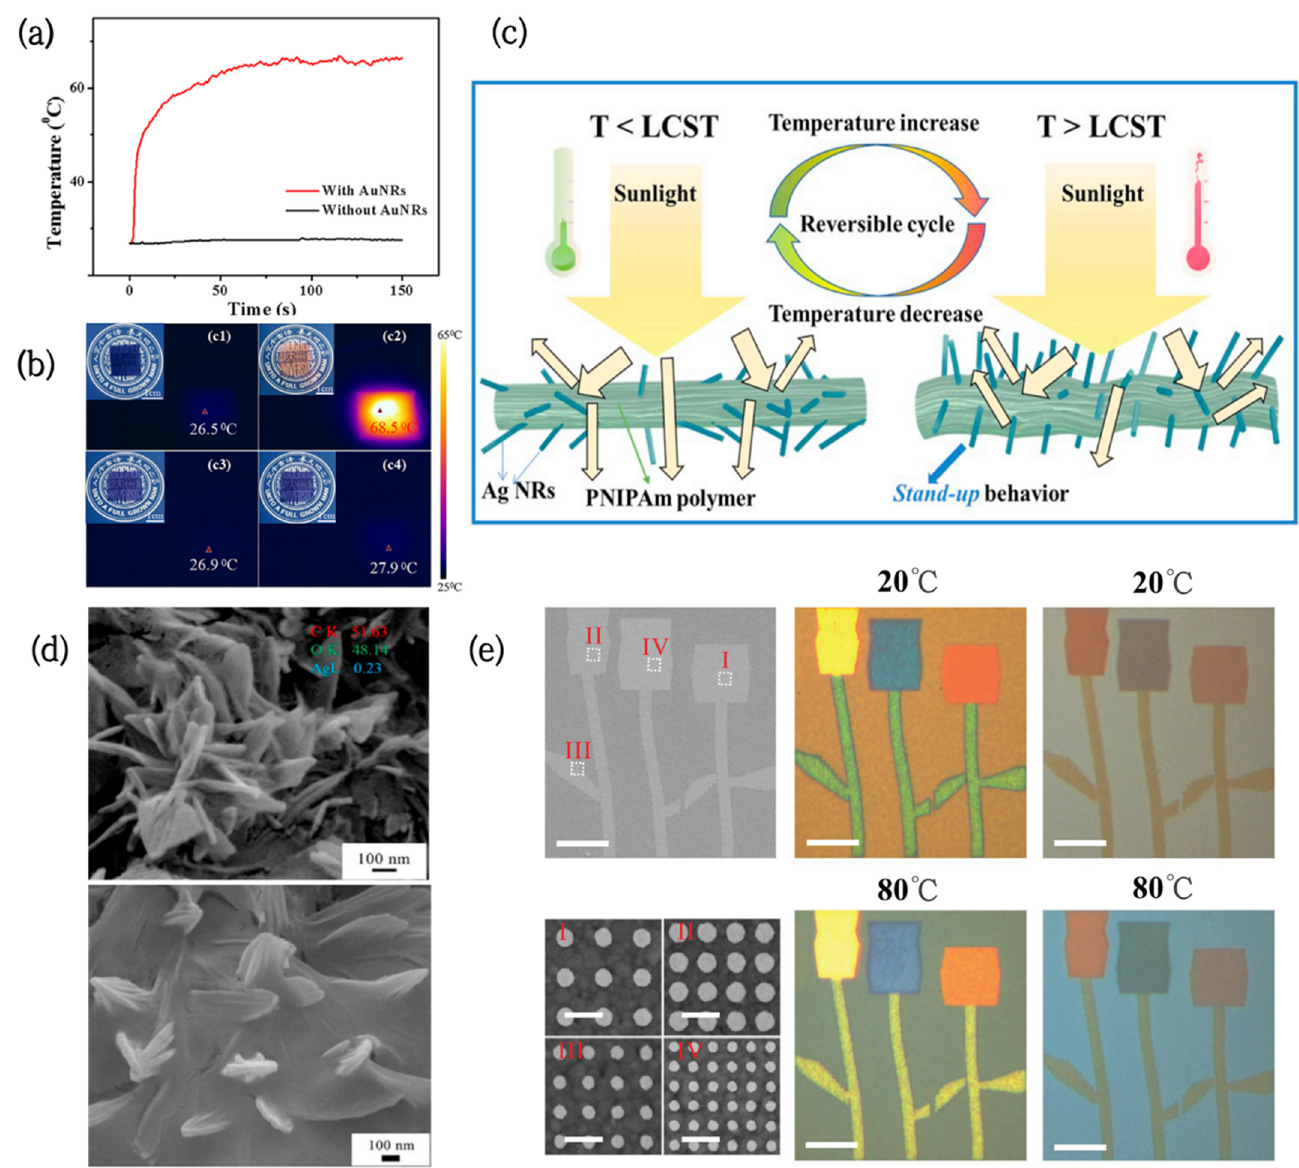
Figure 3. ( a ) Temperature rise curves of PVA/dye films with and without AuNRs [56]. ( b ) Digital photographs and infrared photographs of PVA/dye/AuNRs films and PVA/dye films before and after laser irradiation [56]. ( c ) Schematic representation of the structural shrinkage and deformation of PNIPAm acrylic/AgNRs when the temperature is higher than LCST [57]. ( d ) SEM images of PNIPAm-acrylic acid/AgNRs hydrogels at different temperatures [57]. ( e ) Color patterns constructed from arrays of Ag nanodiscs on silica films at different temperatures [58].